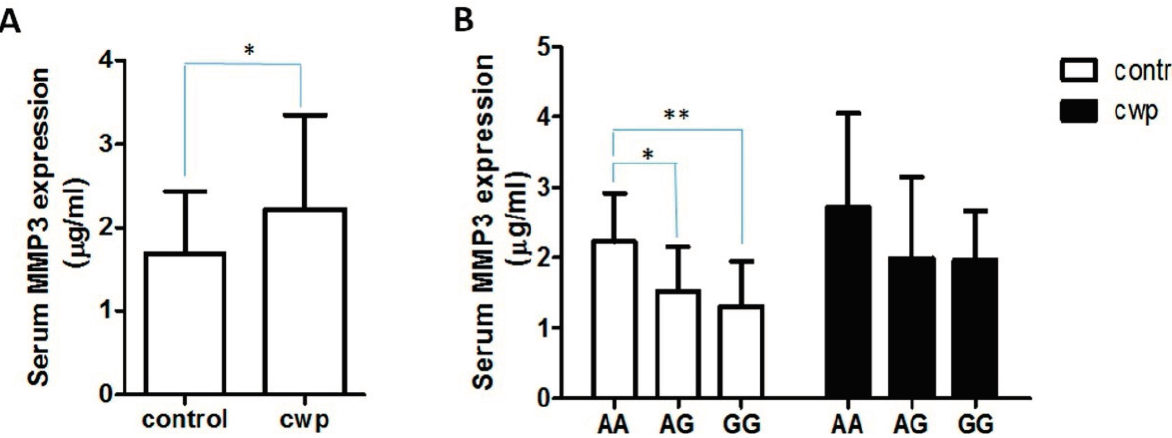
Figure 1. MMP3 expression (mean ± SD) in normal and CWP serum samples. The MMP3 protein expression in serum samples from 36 CWP patients and 36 normal subjects was measured by enzyme-linked immune-sorbent assay (ELISA). ( A ) Serum MMP3 levels were significantly lower in with healthy individuals than those in CWP patients (1.68 ± 0.75 vs . 2.22 ± 1.12 μ g/mL, p = 0.02); ( B ) In the normal serum, there were significantly lower MMP3 among subjects with the rs522616 GG or AG genotype compared with the AA genotype carriers (1.30 ± 0.64 vs . 2.23 ± 0.68 μ g/mL, p < 0.05; 1.52 ± 0.63 vs . 2.23 ± 0.68 μ g/mL, p < 0.01, respectively. n = 12 in each group). However, no statistically significant differences of MMP3 expression were found between GG, AG and AA genotypes in CWP serum samples (1.98 ± 0.70, 2.00 ± 1.16 and 2.72 ± 1.33 μ g/mL. n = 12 in each group). * p < 0.05, ** p <